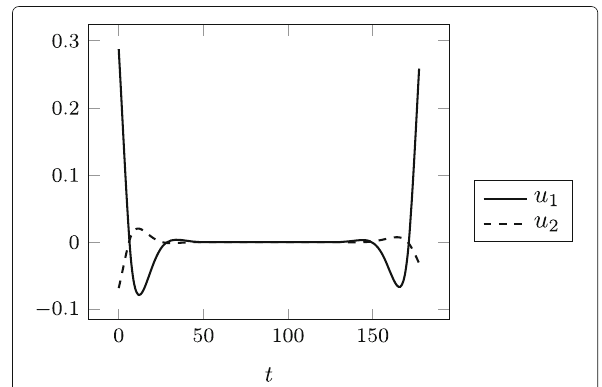
Fig. 24 Time history of control variable u ( t ) for a reorientation